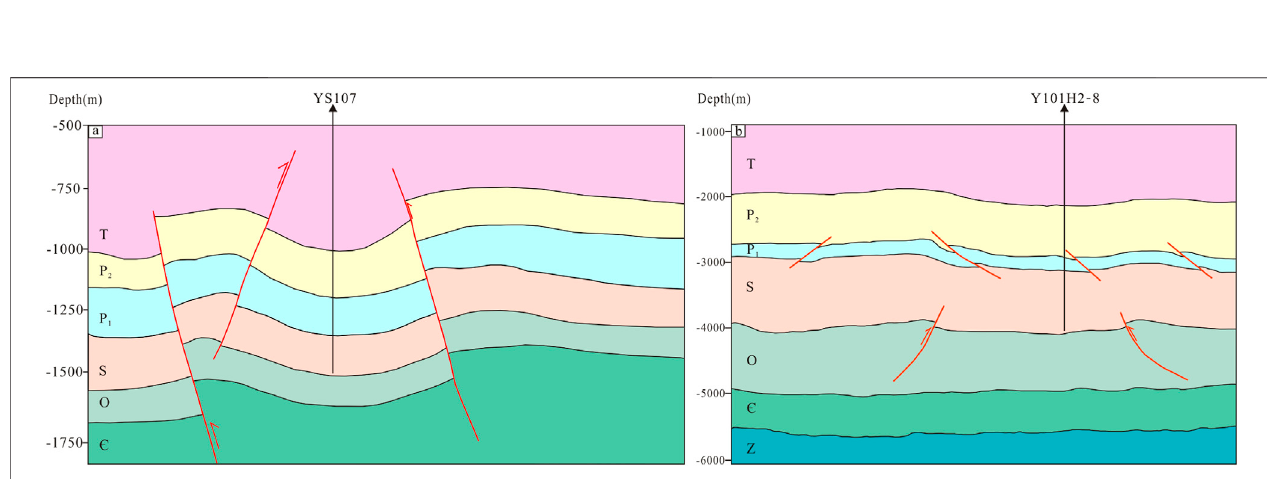
FIGURE 7 | Hedging reverse fault combination. (A) Cross YS107 well pro fi le in Changning area. (B) Cross Y101H2-8 well pro fi le in Luzhou area.